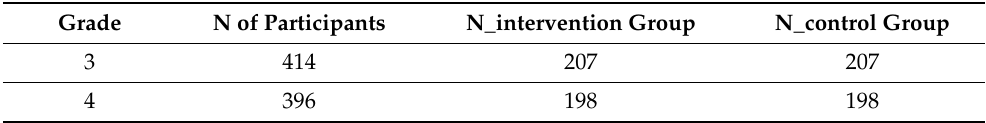
Table 1. Sample of the study. Grade N of